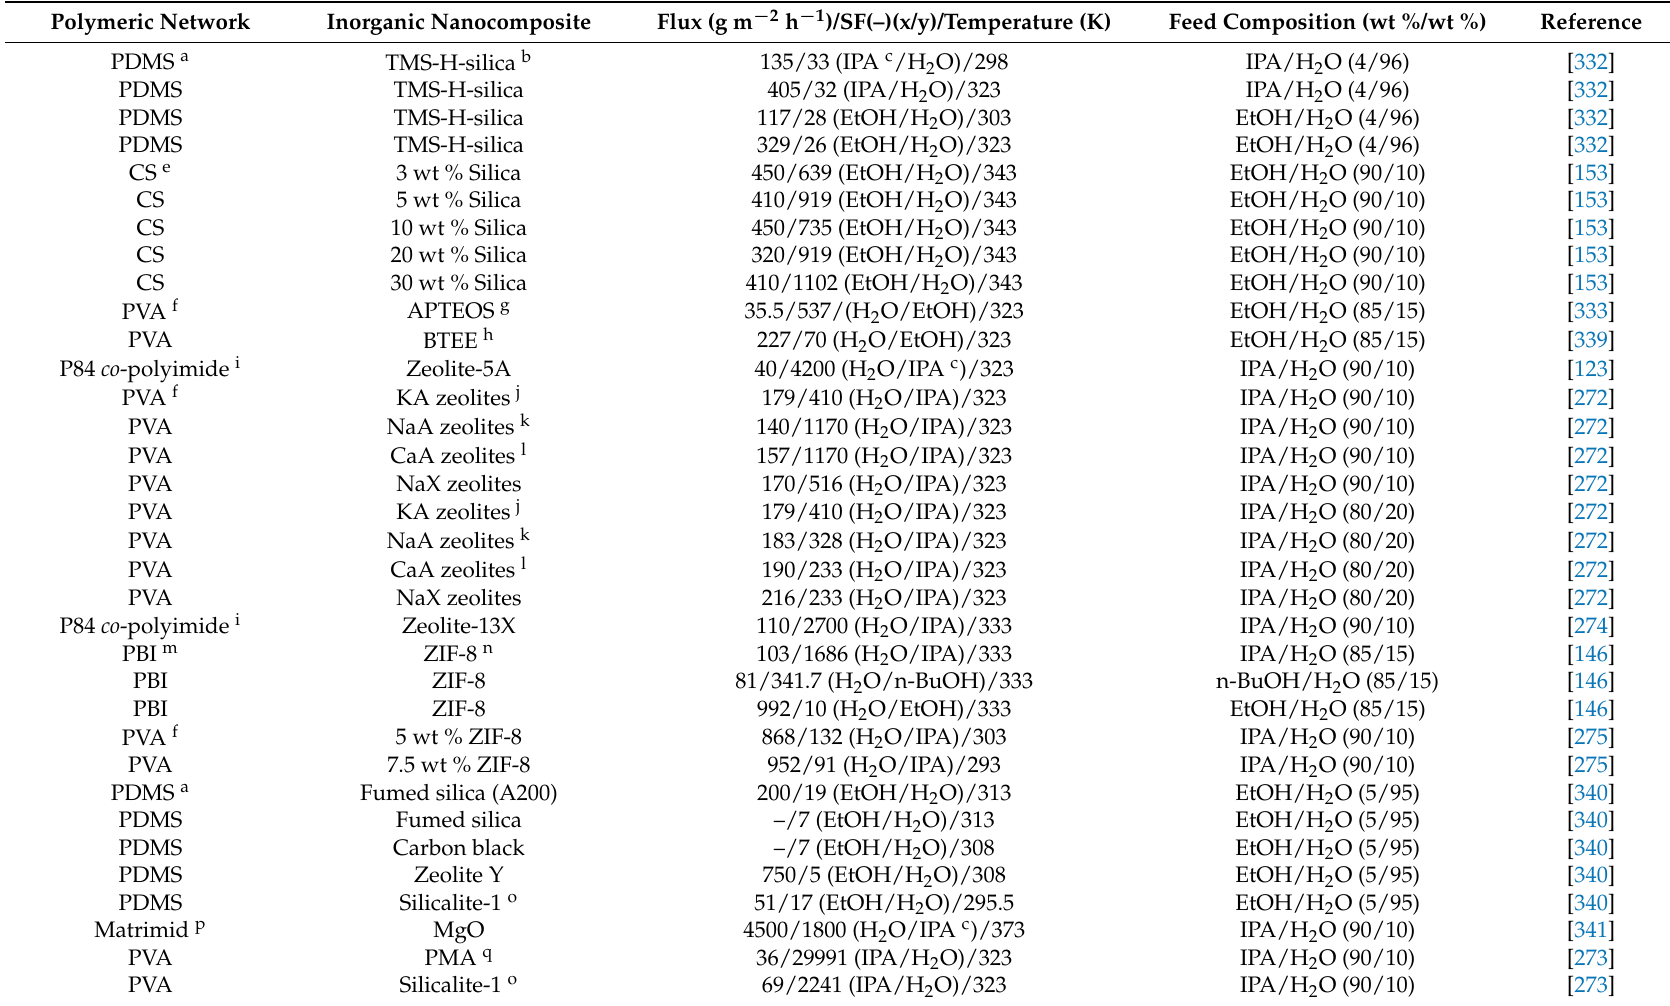
Table 3. Literature study of inorganic NCMs towards PV performance prepared via solution casting and solvent evaporation method